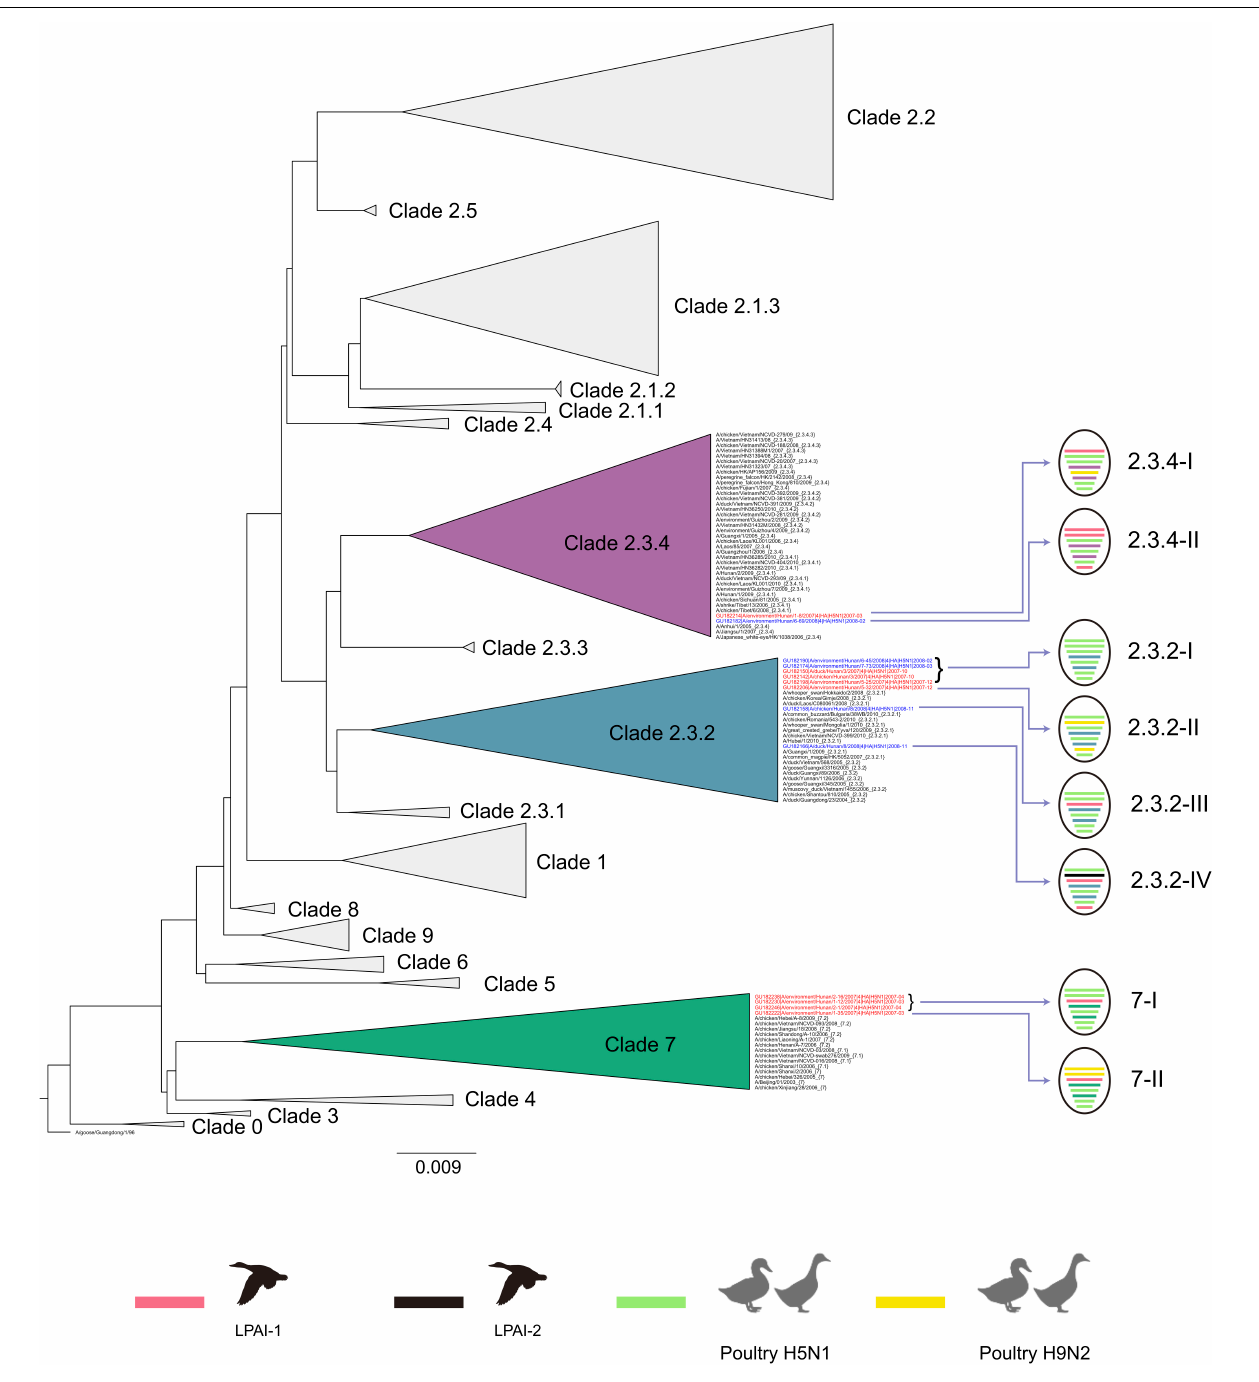
FIGURE 1 | HA Clade and Genotype of isolates in Dongting Lake. Viruses isolated from Dongting Lake in 2007 and 2008 are colored in red and blue, respectively. Genotype of virus are shown in the format of colored ovals with lines that represents the eight genes (from top to bottom: PB2, PB1, PA, HA, NP, NA, MP, and NS). Internal gene segments are colored based on their origin, while HA and NA gene segments are colored according to the HA Clade. Details of phylogenetic trees are available in Supplementary Figure 1 .